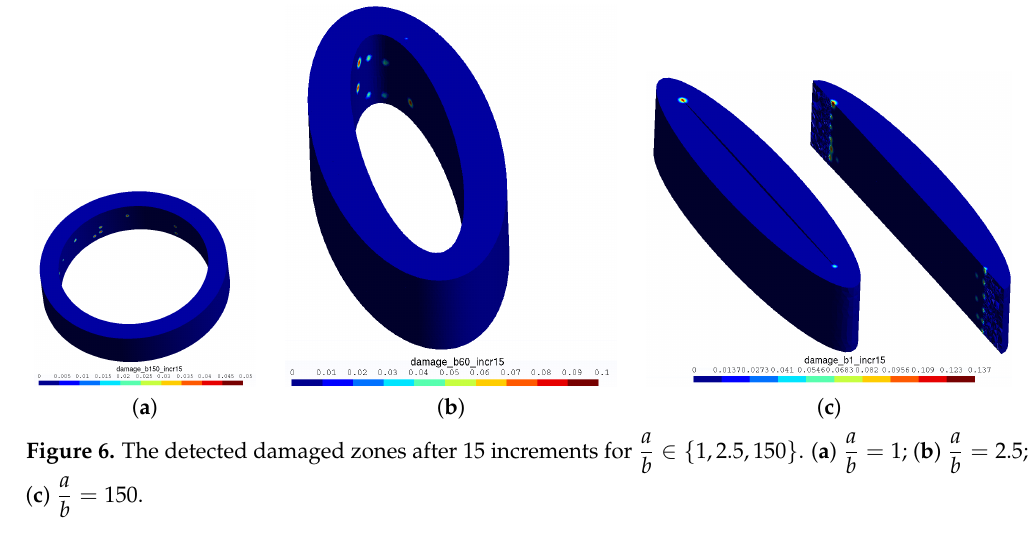
Figure 6. The detected damaged zones after 15 increments for